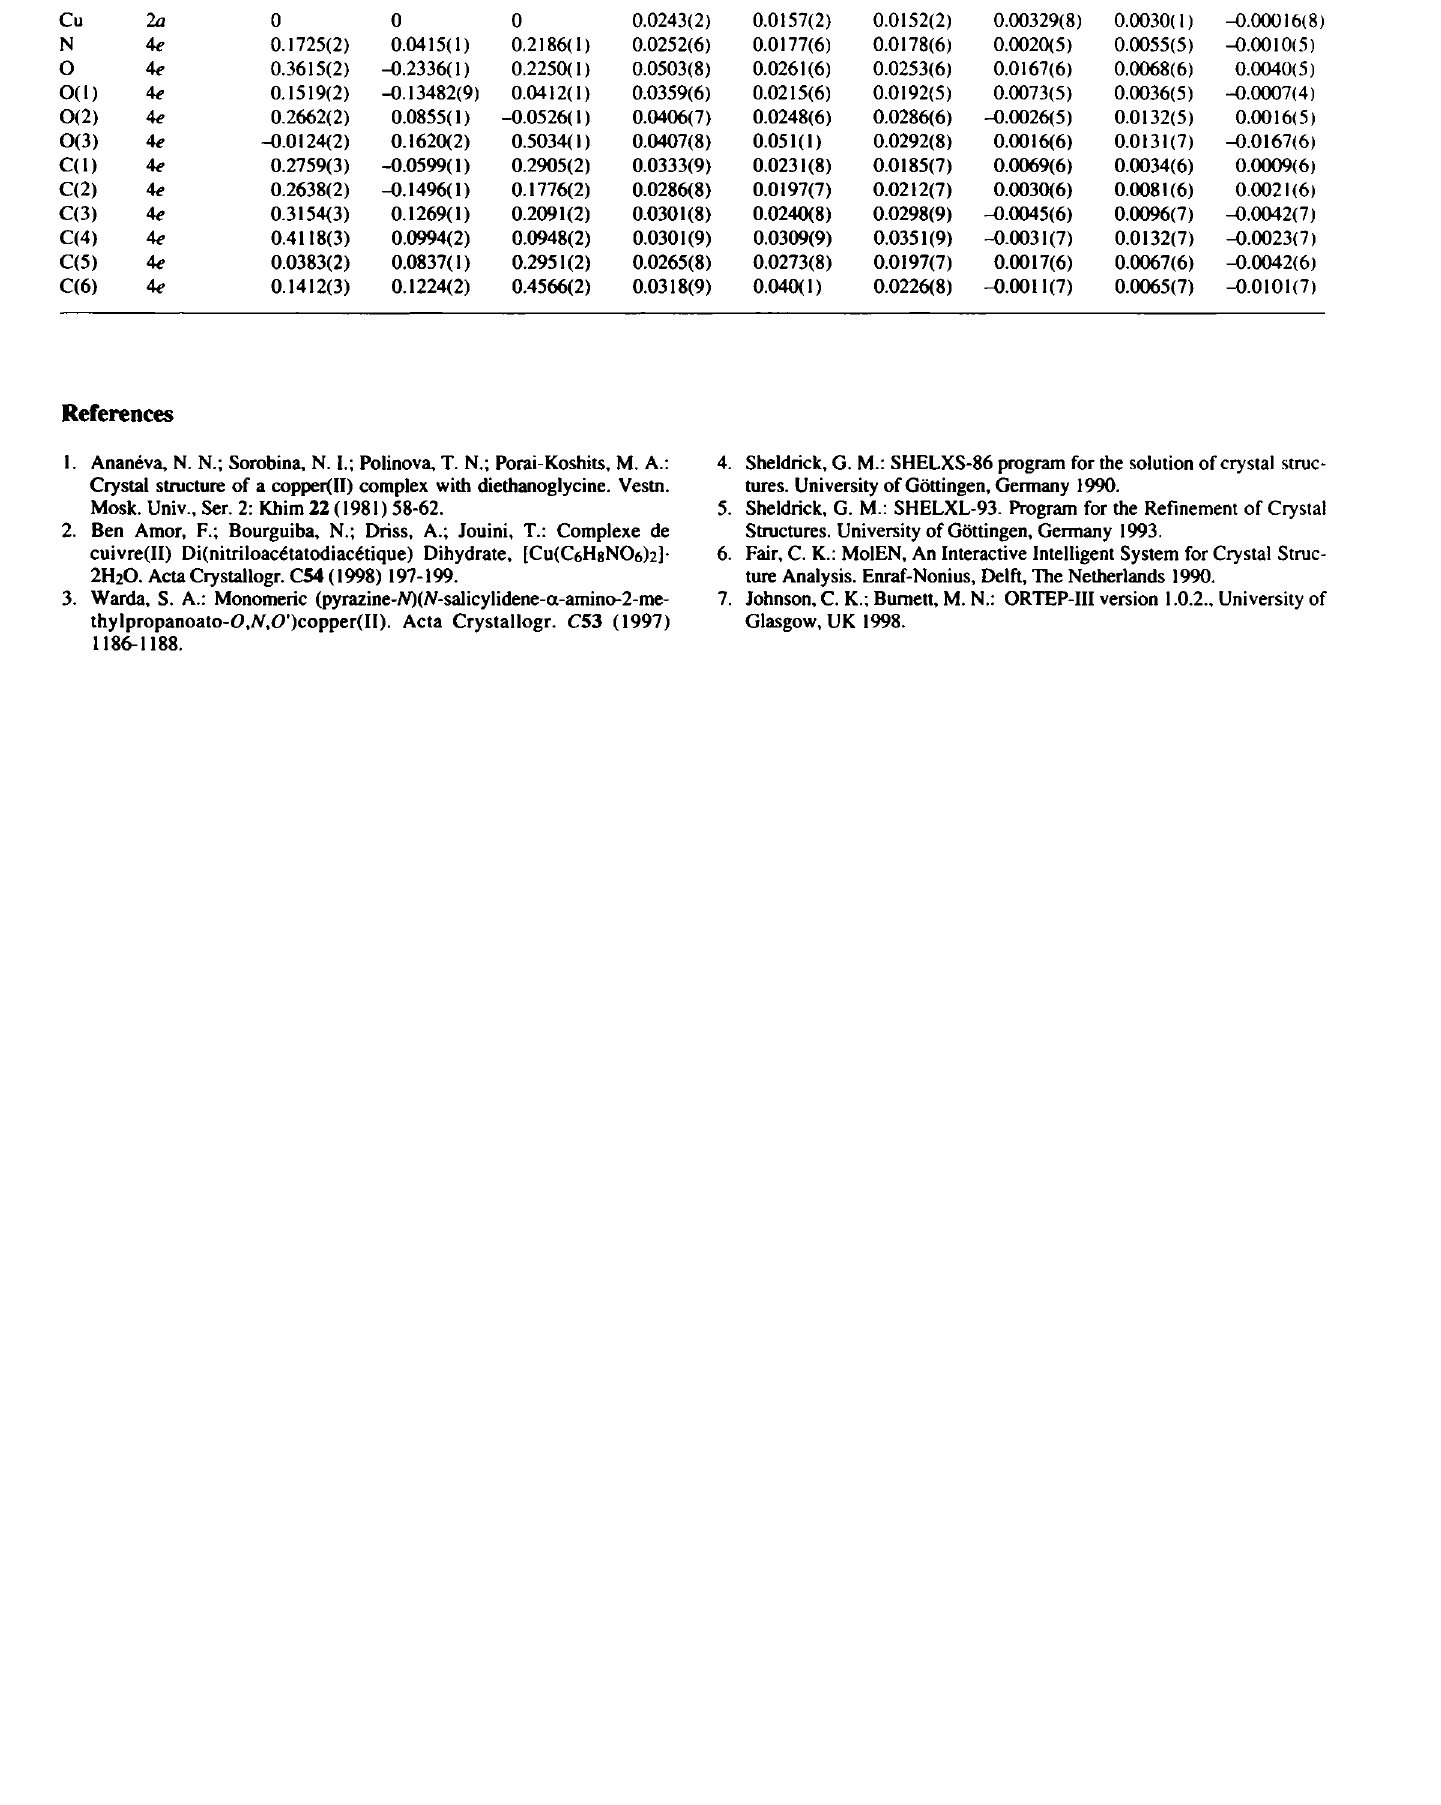
Table 3. Atomic coordinates and displacement parameters (in Ä 2